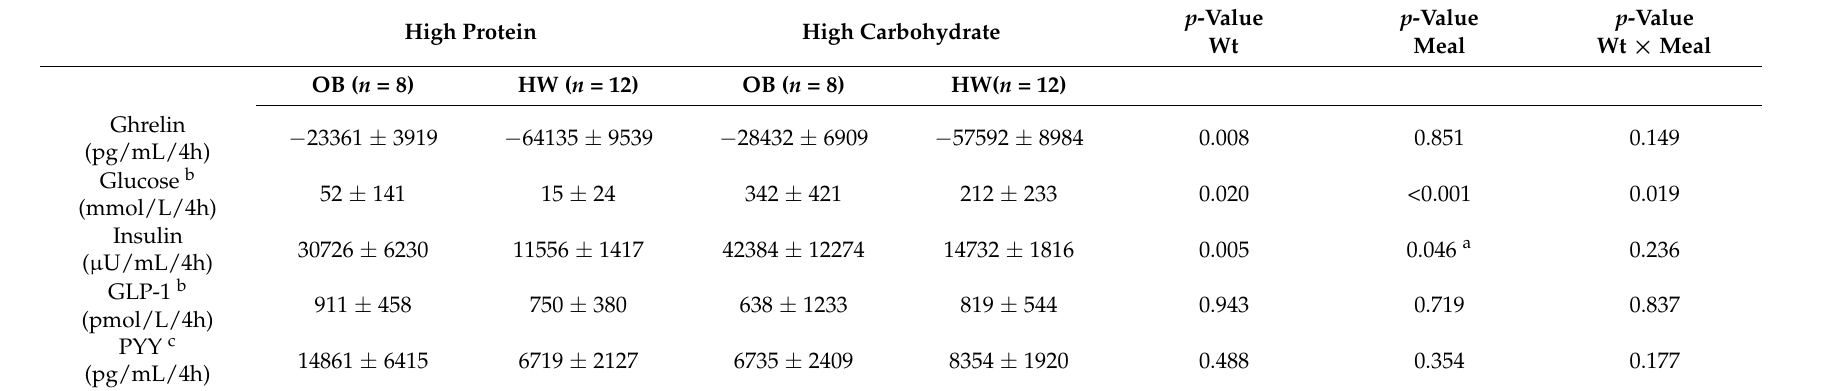
Table 2. The iAUC for ghrelin, glucose, insulin, GLP-1, and PYY in adolescents after meal intake. High Protein High Carbohydrate